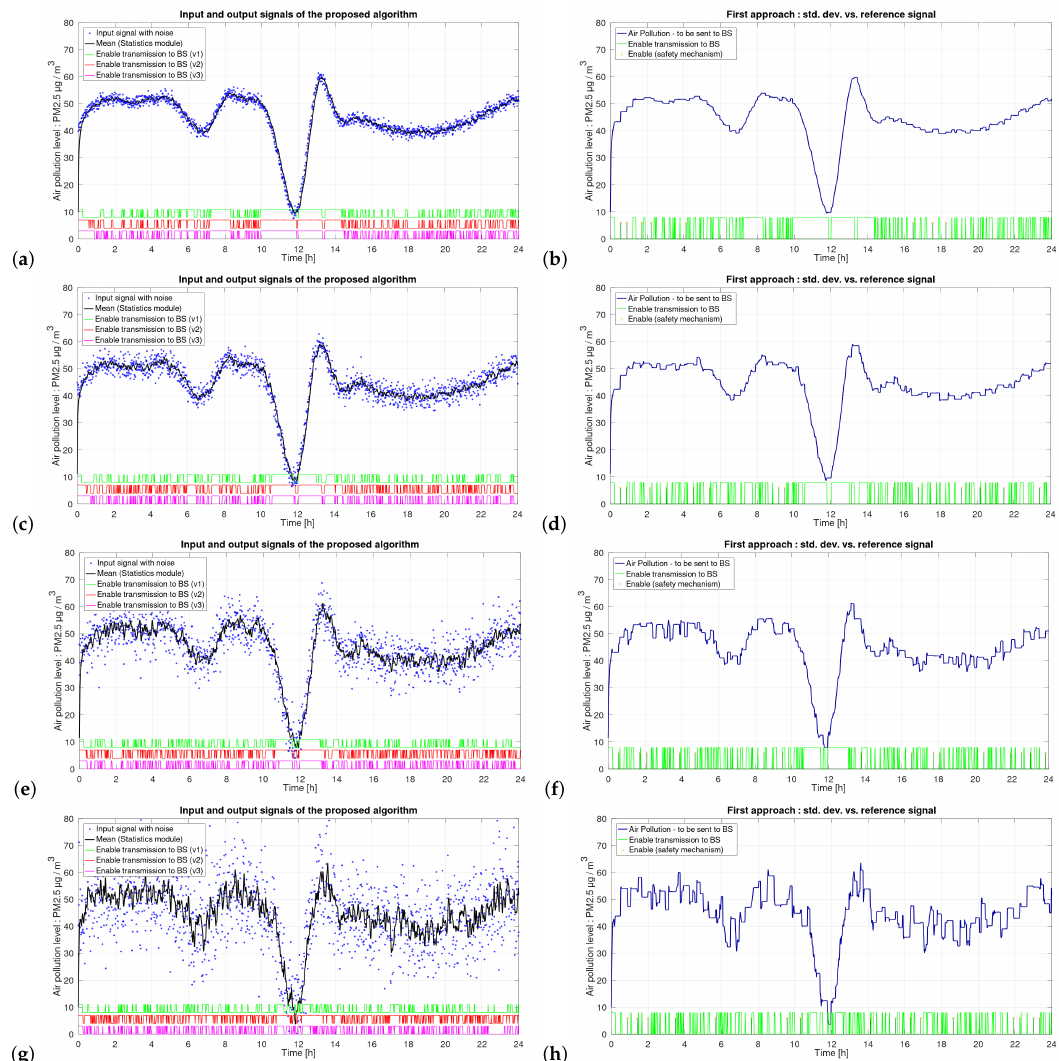
Figure 9. Simulation results for Approach 1, for different maximum values of the noise level and the values of K and N lpf2 of 4. ( a ) Input, mean, and EN signals for noise amplitude of c. 6 PM2.5 µ g/m 3 (10 %); ( b ) Sensor output signal sent to BS; ( c ) Input, mean, and EN signals for noise amplitude of c. 12 PM2.5 µ g/m 3 (20 %); ( d ) Sensor output signal sent to BS; ( e ) Input, mean, and EN signals for noise amplitude of c. 24 PM2.5 µ g/m 3 (40 %); ( f ) Sensor output signal sent to BS; ( g ) Input, mean, and EN signals for noise amplitude of c. 48 PM2.5 µ g/m 3 (80 %); ( h ) Sensor output signal sent to